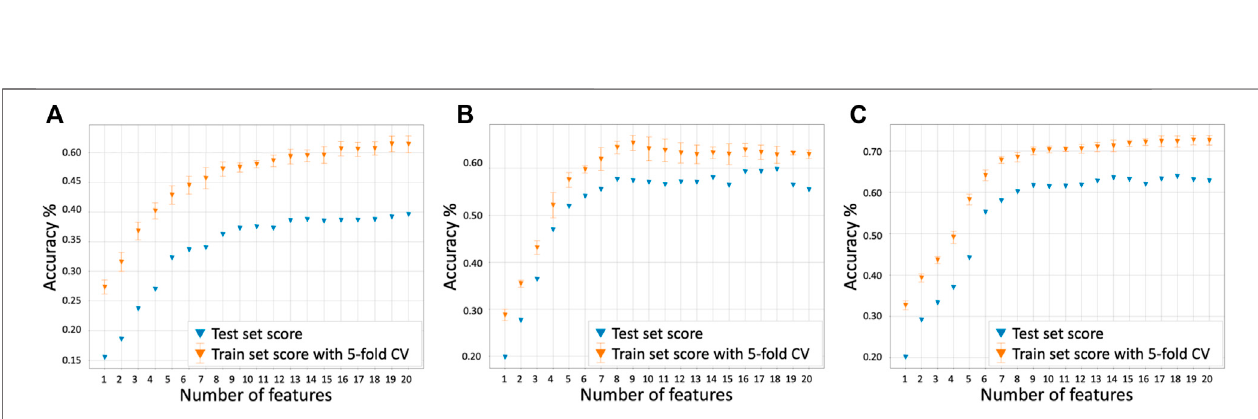
FIGURE 14 | Feature number versus accuracy for Ridge (A) , KNN (B) , and XGBoost (C) .